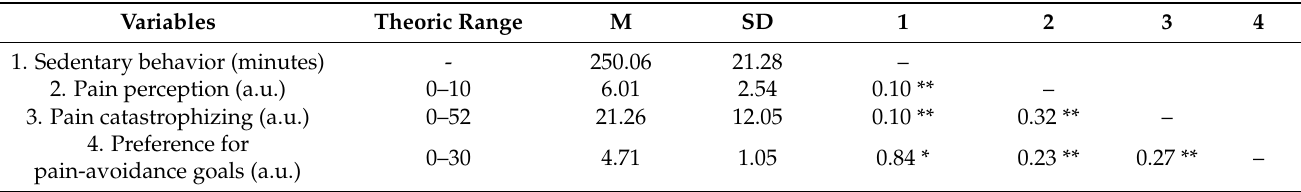
Table 1. Bivariate Pearson correlations between the observed variables ( n = 76).